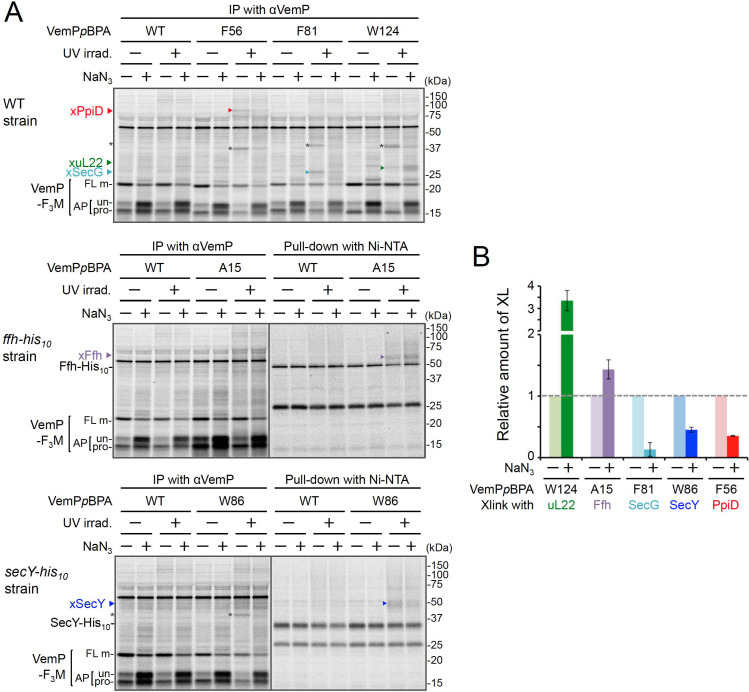
Effects of NaN3 treatment on VemP crosslinking.(A) Wild type cells (upper gel) and mutant cells expressing Ffh-His10 (middle gel), and SecY-His10 (lower gel) from the chromosome were used. The cells were grown, induced to express a VemP-F3M derivatives with pBPA at the indicated position, and analyzed by PiXie as in Figure 1. NaN3 (+) indicates that the cells received 0.02% NaN3 and [35S]Met simultaneously. Labeled proteins were subjected to IP with an anti-VemP antibody (left) or pull-down with Ni-NTA agarose (right) and analyzed as in Figure 1. Asterisks presumably represent crosslinked dimer forms of full-length VemP-F3M. (B) The intensity of these crosslinking bands was quantitated and the relative mean values (the value without NaN3 treatment was set to 1) are plotted with S.D. (n = 3 technical replicates). See Figure 2—figure supplement 4—source data 1 for gel images and quantitated band intensities data.Figure 2—figure supplement 4—source data 1.Zip file containing gel images and quantified band intensity data for the PiXie experiments.